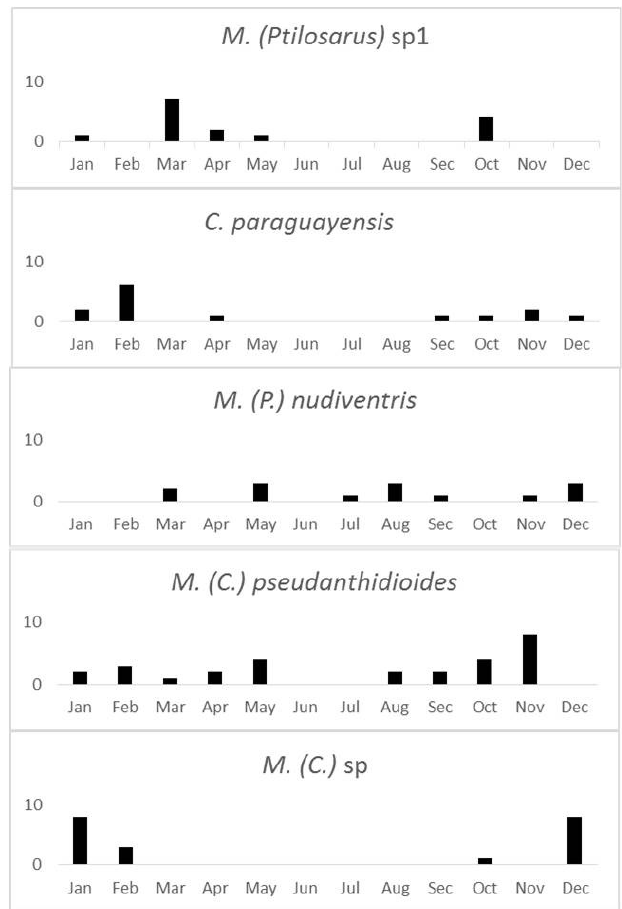
Fig 1 . Nesting activity of Megachilidae bees (number of nests constructed in trap-nests) in the União Biological Reserve, RJ, Brazil, from Mar, 2008 to Oct, 210 and from Mar, 2012 to Mar,